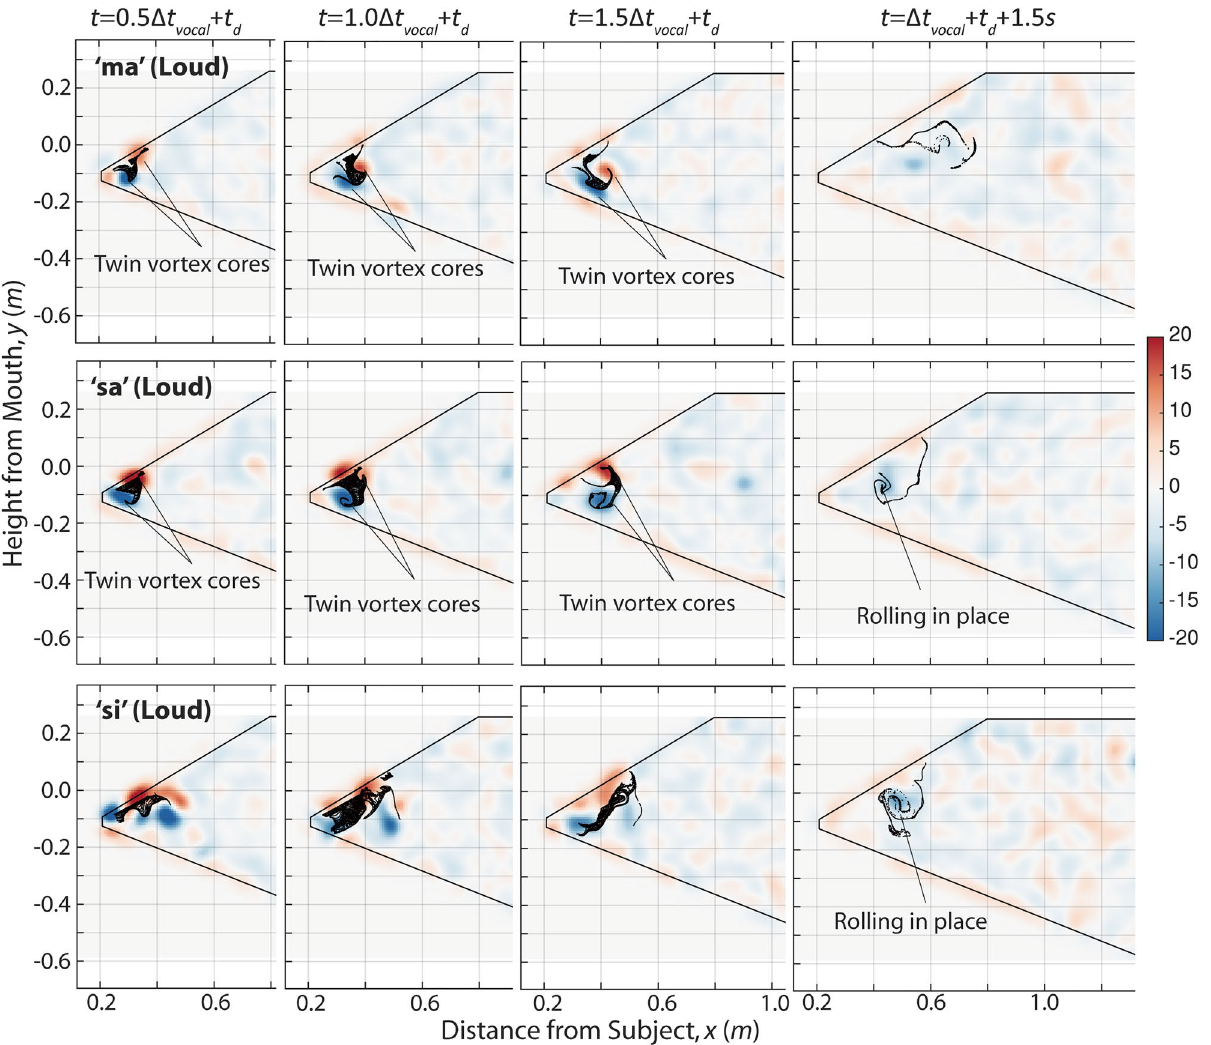
Figure 4. Dispersion dynamics of aerosol particles for nasal and fricatives. Background: vorticity in s −1